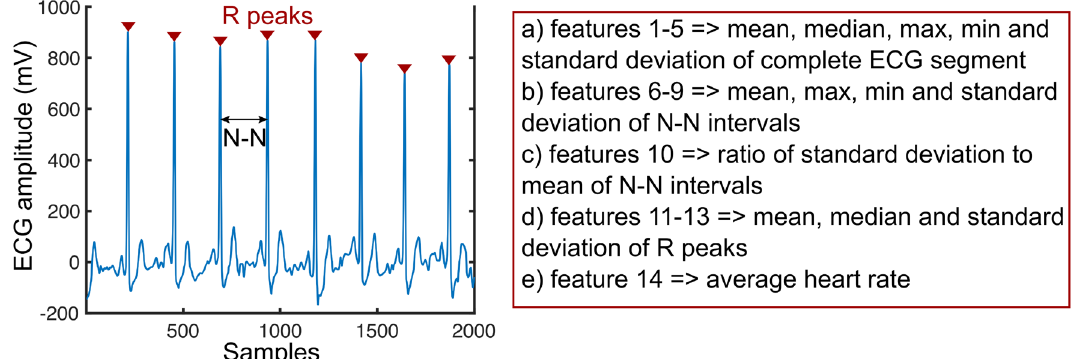
Figure 5. Summary of time-domain features extracted from ECG signal.